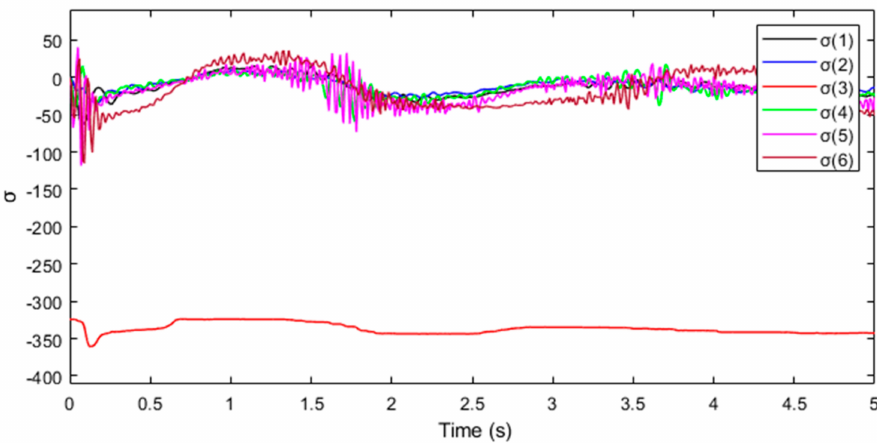
Figure 6. Curve trajectory of parameter σ in complex